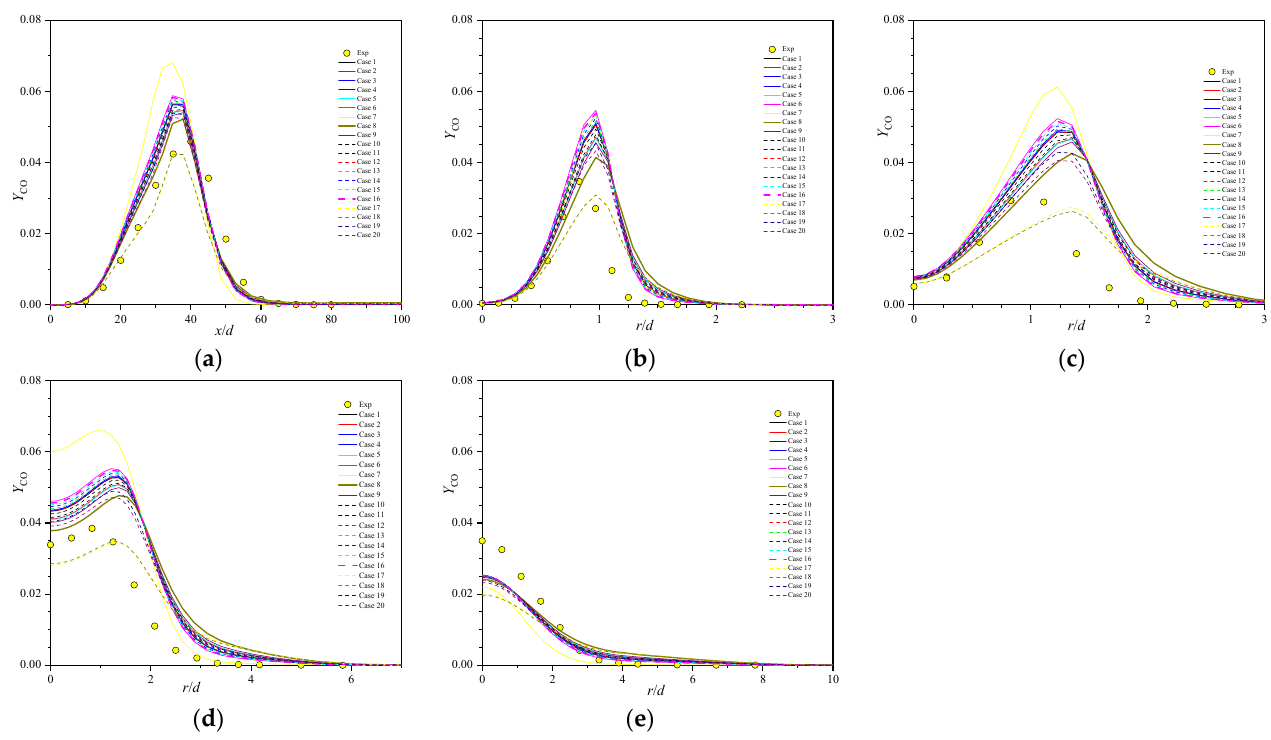
Figure 11. Comparison of measured [22,24] and predicted mean CO mass fraction profiles for the Sandia Flame D with 20 combinations of the primary EDC constants C D1 and C D2 . ( a ) @axis. ( b ) @ x / d = 7.5. ( c ) @ x / d = 15. ( d ) @ x / d = 30. ( e ) @ x / d = 45.